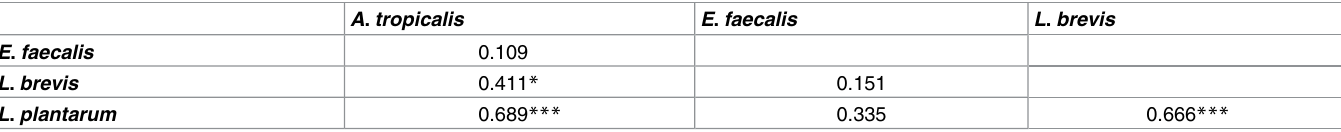
Table 2. Correlations between relative commensal bacterial level.